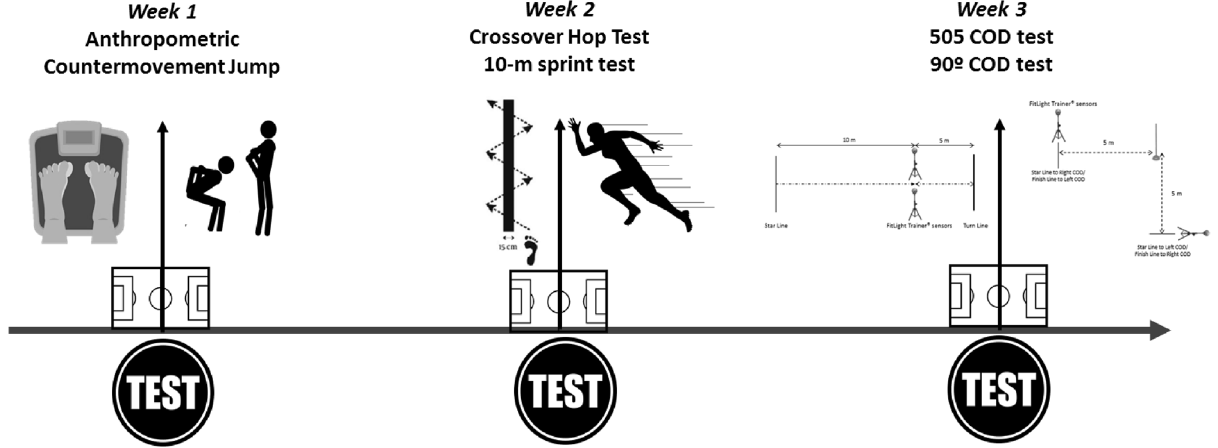
Figure 1. Schematic representation of a test day (see text for full